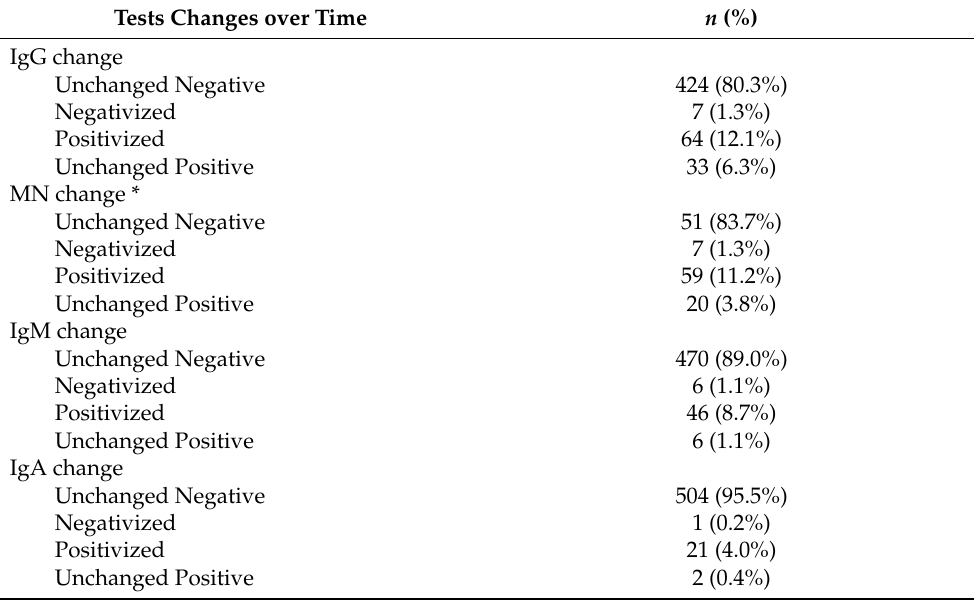
Table 4. Change in IgG, IgM, IgA and MN between the first trimester of pregnancy (T0) and peripartum (T1).